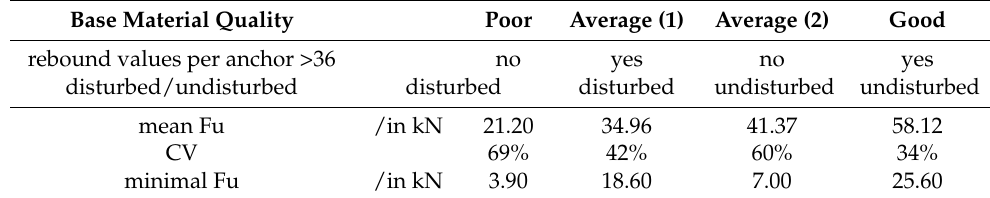
Figure 13. Relationship between rebound values and failure loads–anchors where R values do not fall below threshold are highlighted. Table 5. Base material classification.